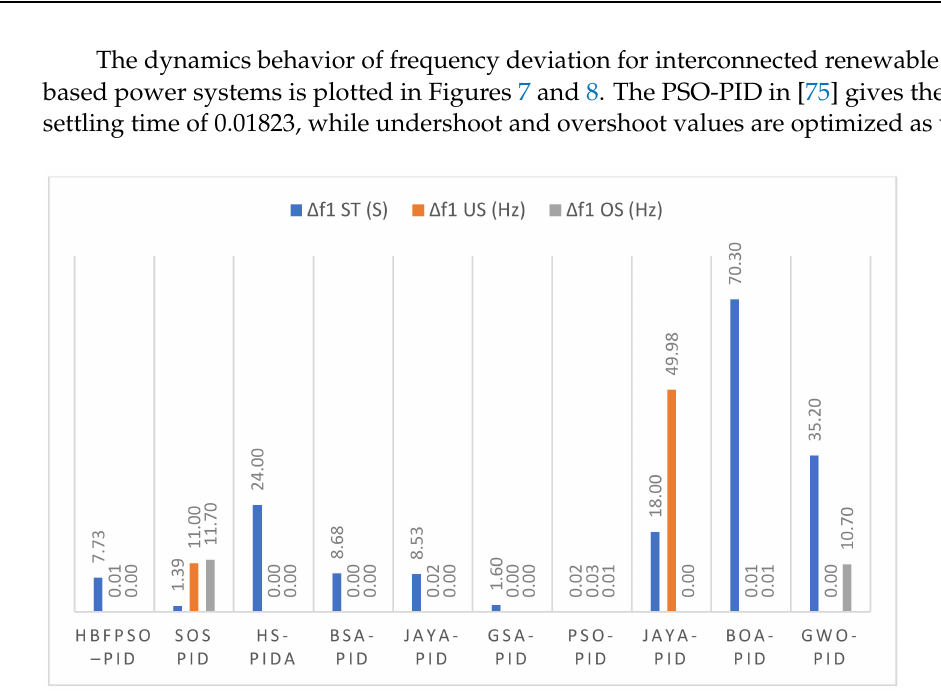
Figure 7. Frequency Deviation for Interconnected Systems.